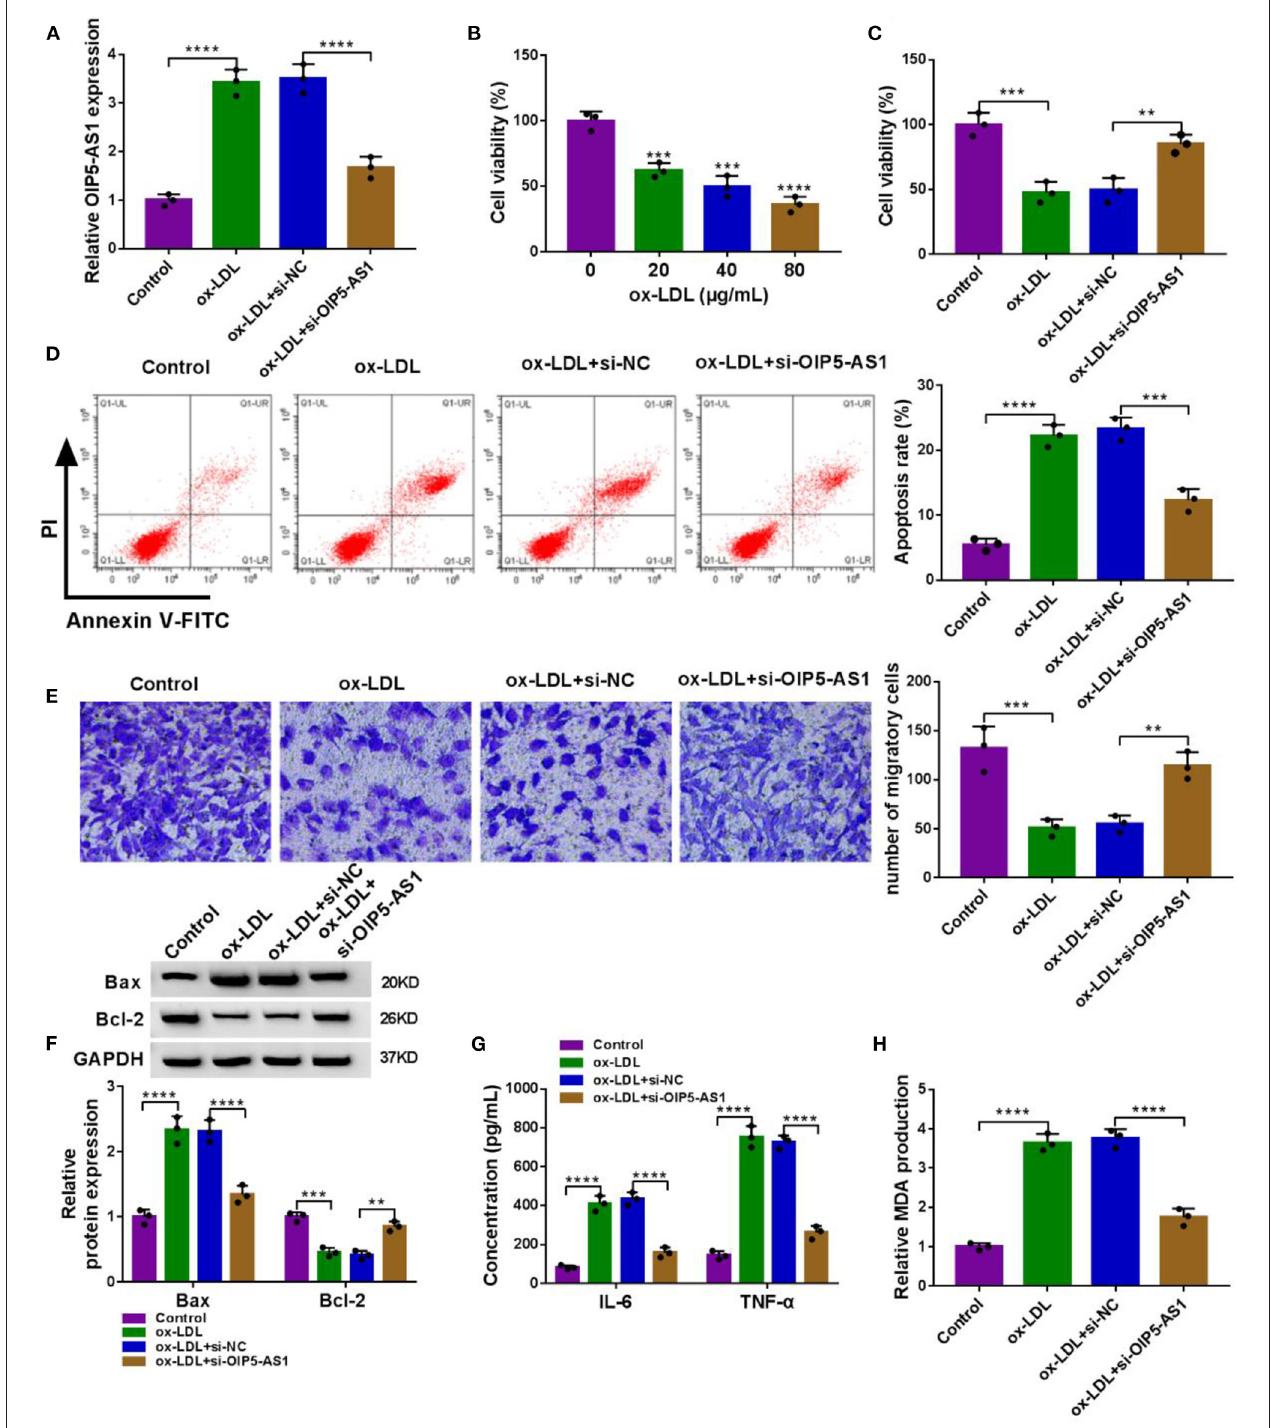
FIGURE 2 | OIP5-AS1 silencing relieved ox-LDL-triggered cytotoxicity in HUVECs. (A) OIP5-AS1 expression by qRT-PCR in HUVECs transfected with or without si-OIP5-AS1 or si-NC before ox-LDL stimulation (40 µ g/ml, 24h). n = 3 independent biological replicates; error bars represented SD; **** P < 0.0001 by one-way ANOVA with Tukey’s post hoc test. (B) CCK-8 assay for cell viability in HUVECs stimulated with 20, 40, and 80 µ g/ml of ox-LDL for 24h. n = 3 independent biological replicates; error bars represented SD; *** P < 0.001 or **** P < 0.0001 by one-way ANOVA with Tukey’s post hoc test. CCK-8 assay for cell viability (C) , flow cytometry for cell apoptosis (D) , Transwell assay for cell migration (E) , western blot for Bax and Bcl-2 levels (F) , ELISA for IL-6, TNF- α , and MDA levels (G,H) in HUVECs transfected with or without si-OIP5-AS1 or si-NC before 40 µ g/ml of ox-LDL stimulation for 24h. n = 3 independent biological replicates; error bars represented SD; ** P < 0.01, *** P < 0.001, or **** P < 0.0001 by one-way ANOVA with Tukey’s post hoc test.